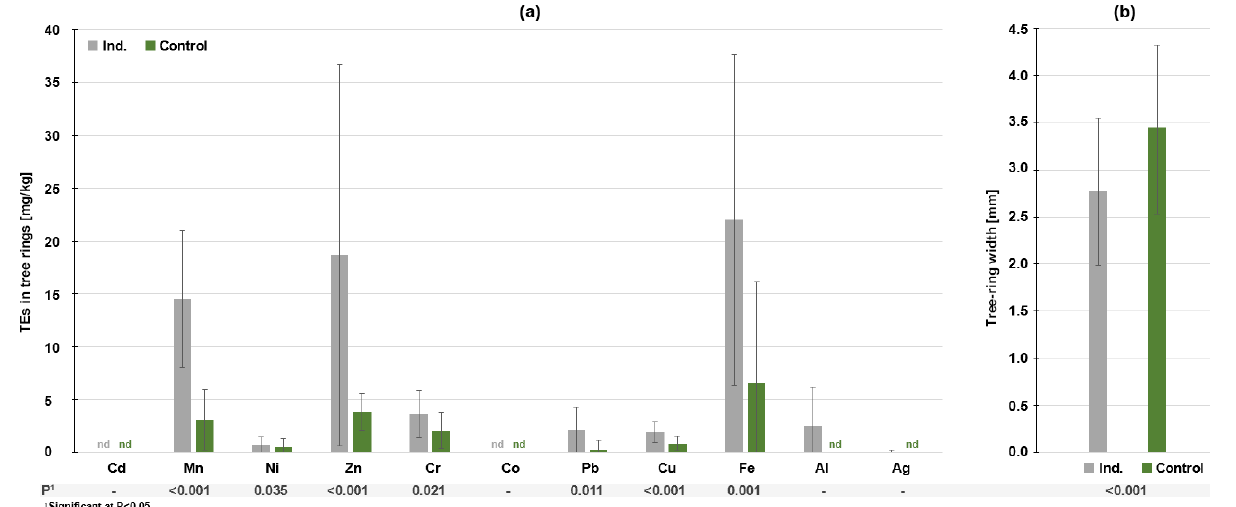
Figure 2. ( a ) Mean trace element (TE) contents [mg/kg] in the tree rings of pedunculate oak in different study sites (Control vs. Industrial (Ind.)) between 1959 and 2014 (with standard deviation ( ± SD) error bars). Values below the limit of detection (LOD) were marked as nd (not detected); ( b ) Mean tree rings’ widths (TRWs) of trees growing at the Iwiny Industrial and Control site between 1959 and 2014 (with standard deviation ( ± SD) error bars).